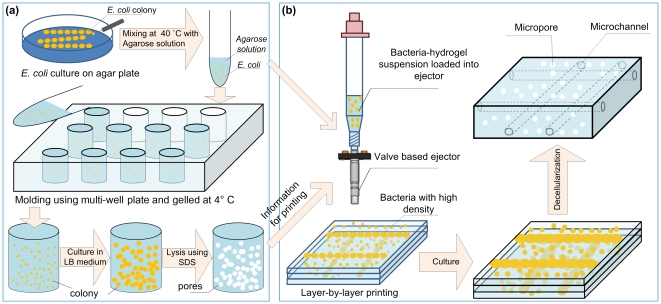
Illustration of the fabrication steps of microporous hydrogel scaffolds using living sacrificial porogens.(a) E. coli encapsulation in hydrogels as porogens and live sacrificial pore formation. E. coli cultured on LB agar plate were collected and mixed with the agarose solution. After mixing, E. coli suspension was poured into a 12-well plate and solidifies. E. coli encapsulated in hydrogels were continuously cultured to allow formation of colonies. The living porogens were then lysed and the debris of E. coli and its DNA were removed by sequential washing with DPBS and DI water. (b) Formation of microfluidic channels. A line of E. coli / agarose mixture solution was printed onto Petri dish pre-coated with a layer of agarose. Then, another layer of agarose was used to cover the bacterial line. The hydrogels were gelled under rapid cooling (4°C) overnight.